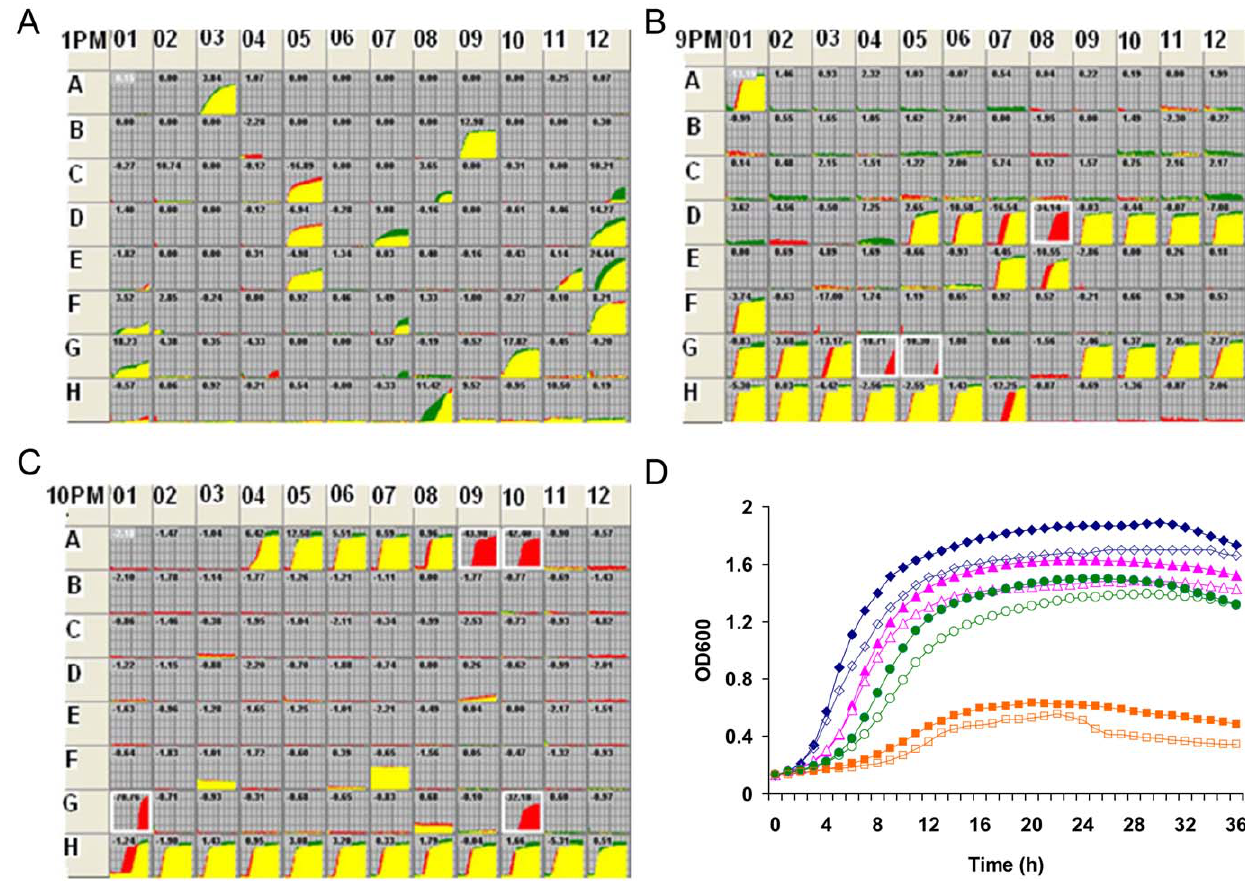
Figure 6. Involvement of the EnvZ-OmpR system in metabolism and stress response. (A, B, C) The envZ / ompR mutation strain was subjected to PM analysis (3 PMs). The PM kinetic profile shown by comparing the ompR-envZ mutant (green) and its wild-type parental strain (red). Red indicates a stronger response by MR-1, and green indicates a stronger response by the mutant; when the two strains have equivalent metabolism or equivalent growth responses in a well, the red and green kinetic graphs overlap and are yellow. A box around a growth curves indicates a significant difference in response. (D). Independent growth studies in LB with various concentrations of sodium sulfate. 2%, diamond; 3%, triangle; 4%, cycle; 5%, square. In all cases, MR-1, closed; ompR-envZ- , open. Experiments were performed three times independently and consistent results were obtained. For clarity, error bars (SEM, , 5%) were omitted in the figure.